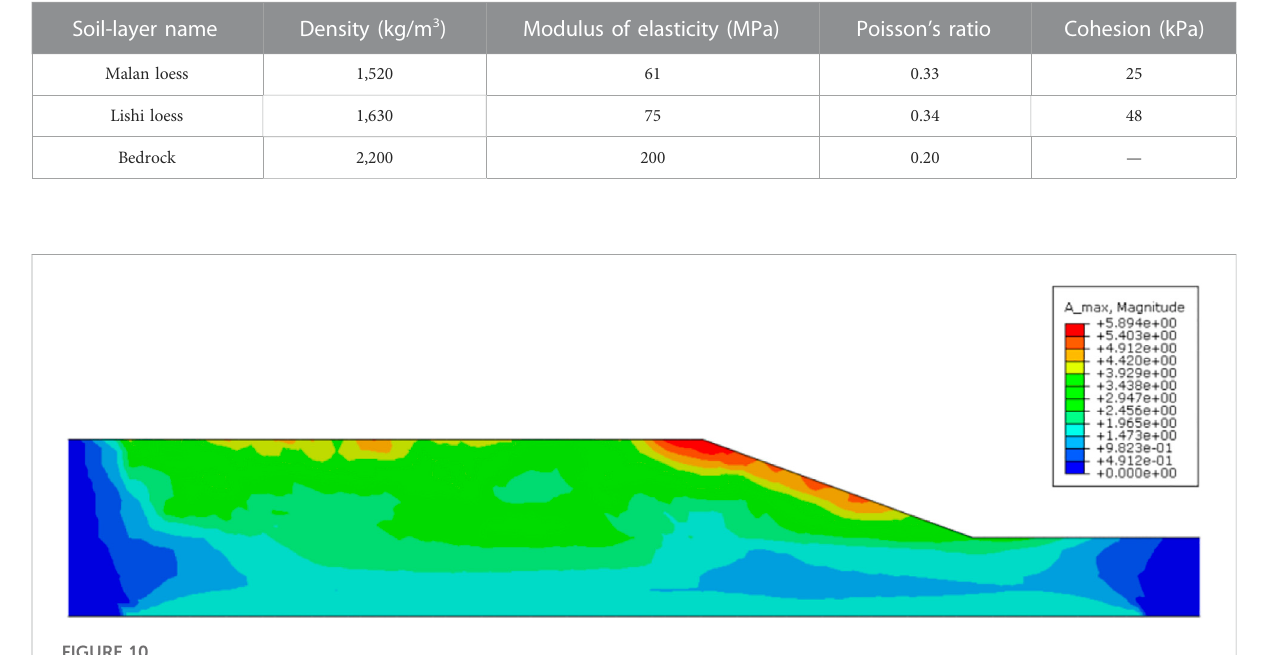
FIGURE 10 Seismic acceleration cloud of the loess slope by numerical